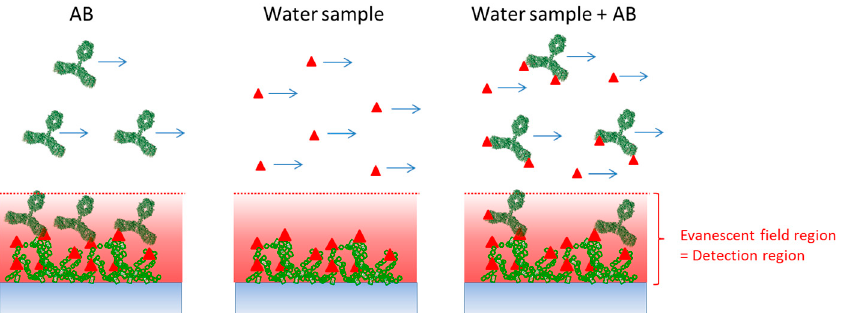
Figure 2. Schematic of the competitive bioassay principle used for the detection of atrazine.